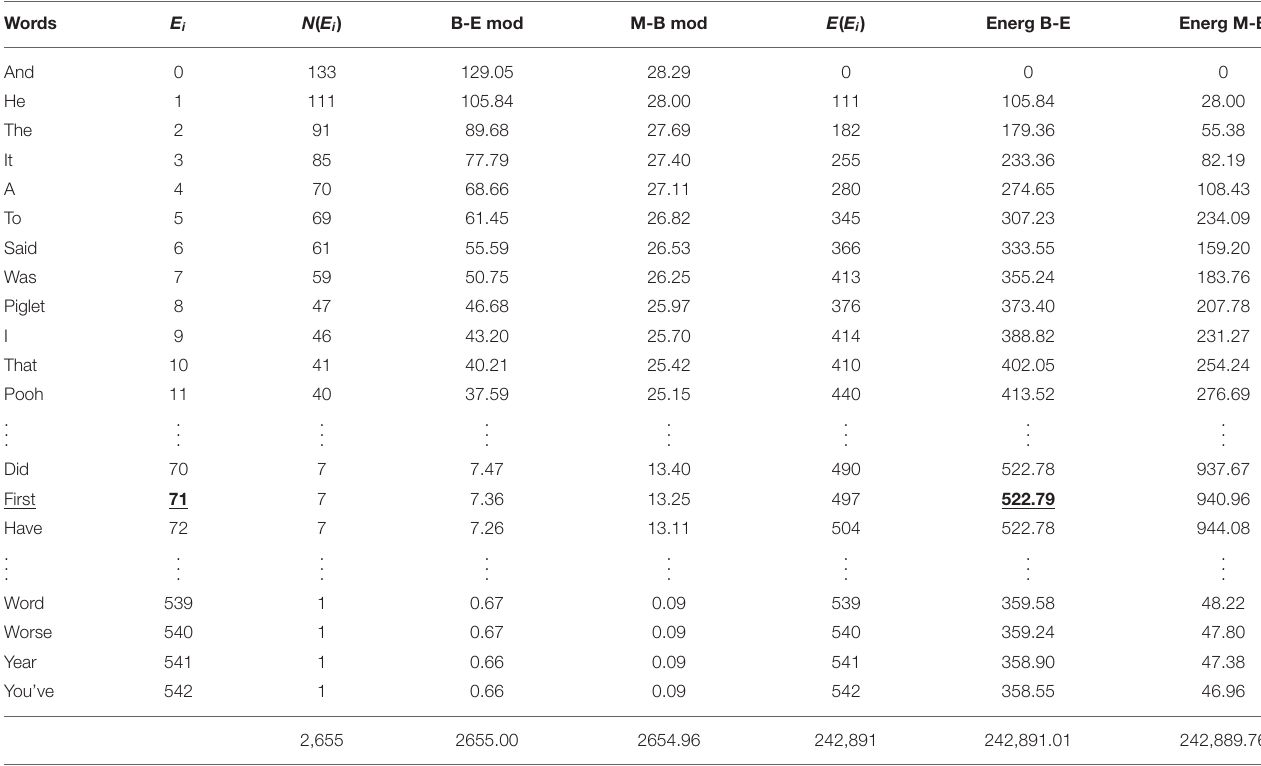
TABLE 1 | An energy scale representation of the words of the Winnie the Pooh story “In Which Piglet Meets a Haffalump” by A. A. Milne as published in Milne (1926). Words